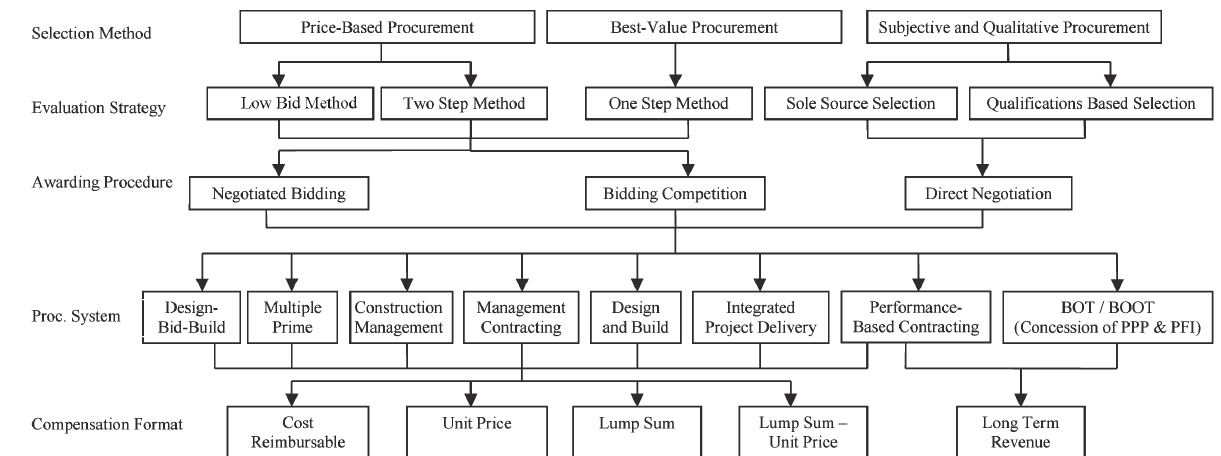
Fig. 1. Procurement routes